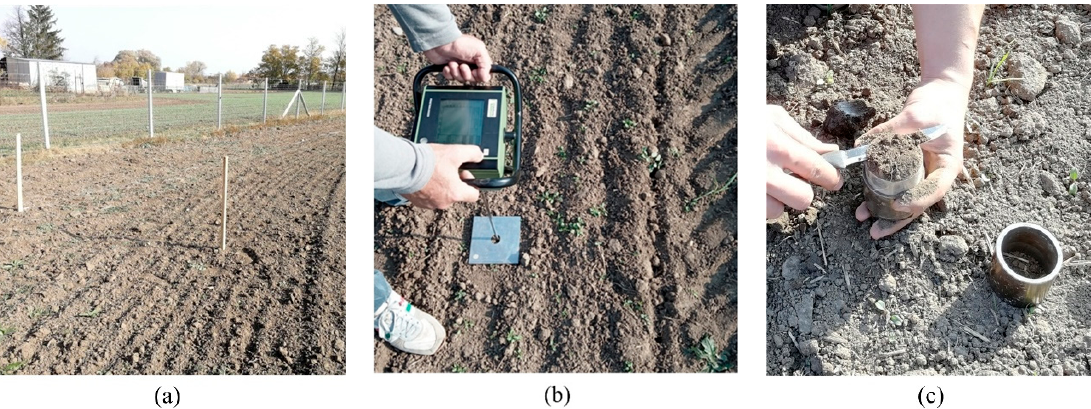
Figure 7. Experimental field: ( a ) Area bounded by plot stakes; ( b ) Measurement of penetrometer resistance outside the tire track using the handheld penetrologger; ( c ) Soil sampling by Kopecky’s soil core samplers.